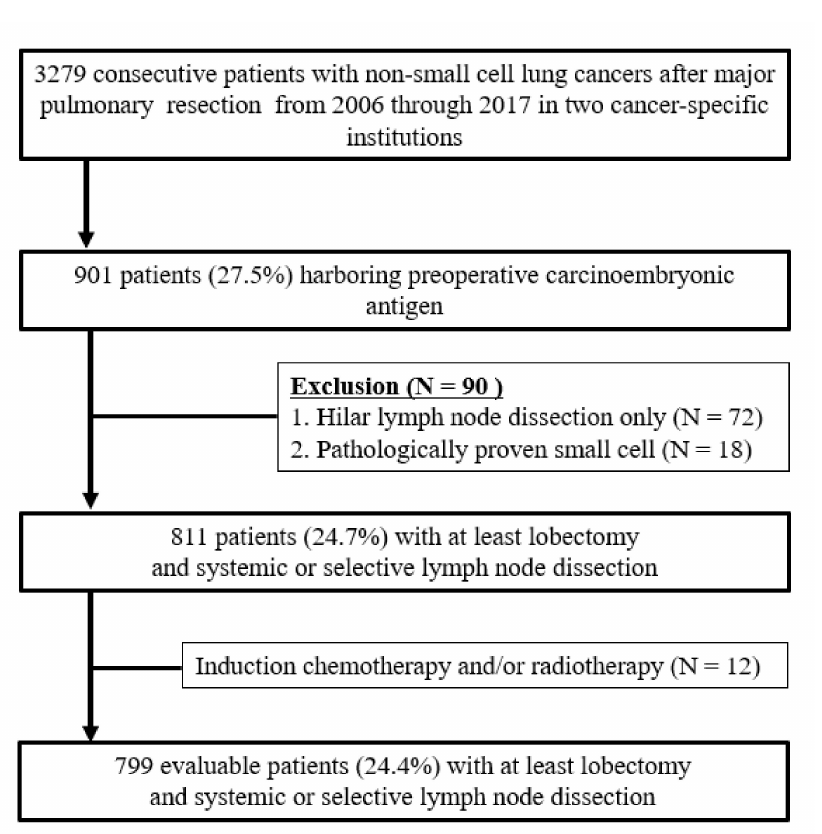
Figure 1. Flow chart of patient selection